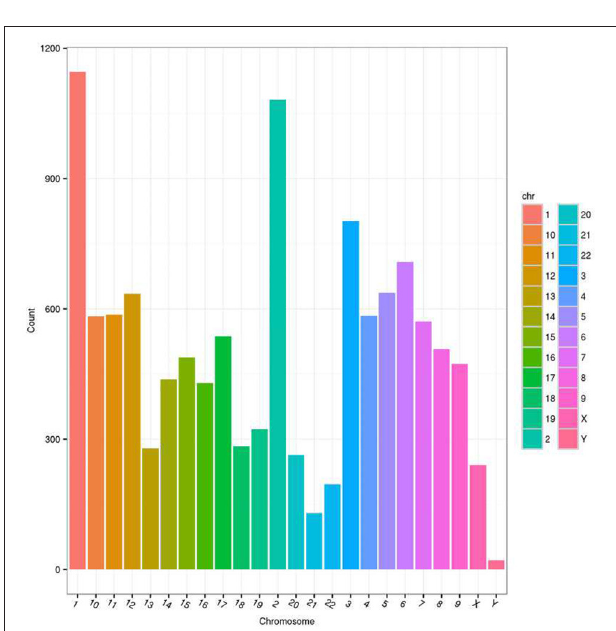
FIGURE 4 | The distribution of differentially expressed circRNAs in human